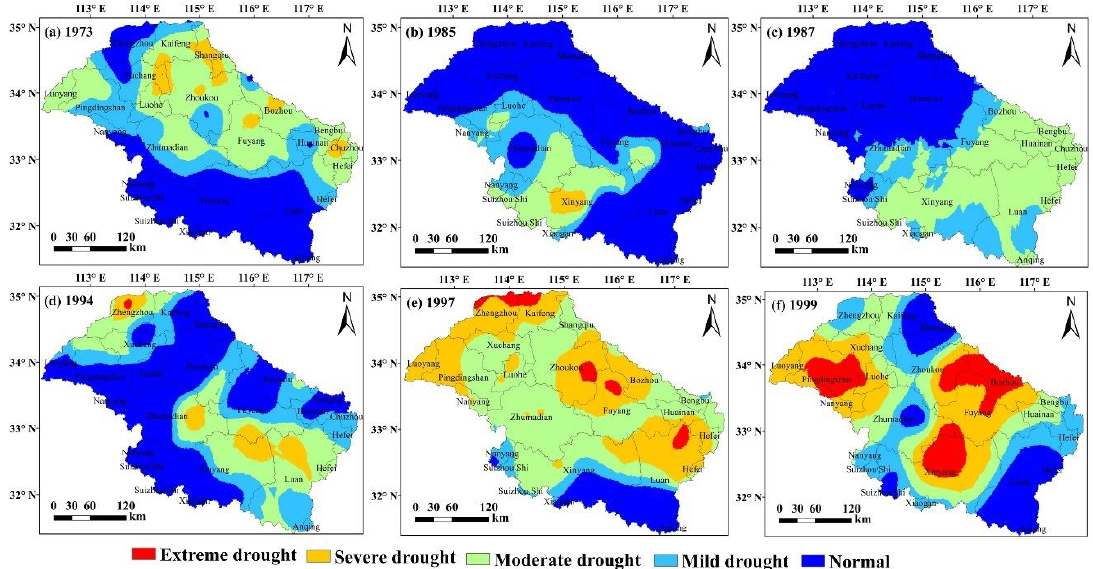
Figure 7. Validation of typical years of precipitation thresholds of drought disaster in summer maize: ( a ) 1973, ( b ) 1985, ( c ) 1987, ( d ) 1994, ( e ) 1997, and ( f ) 1999.